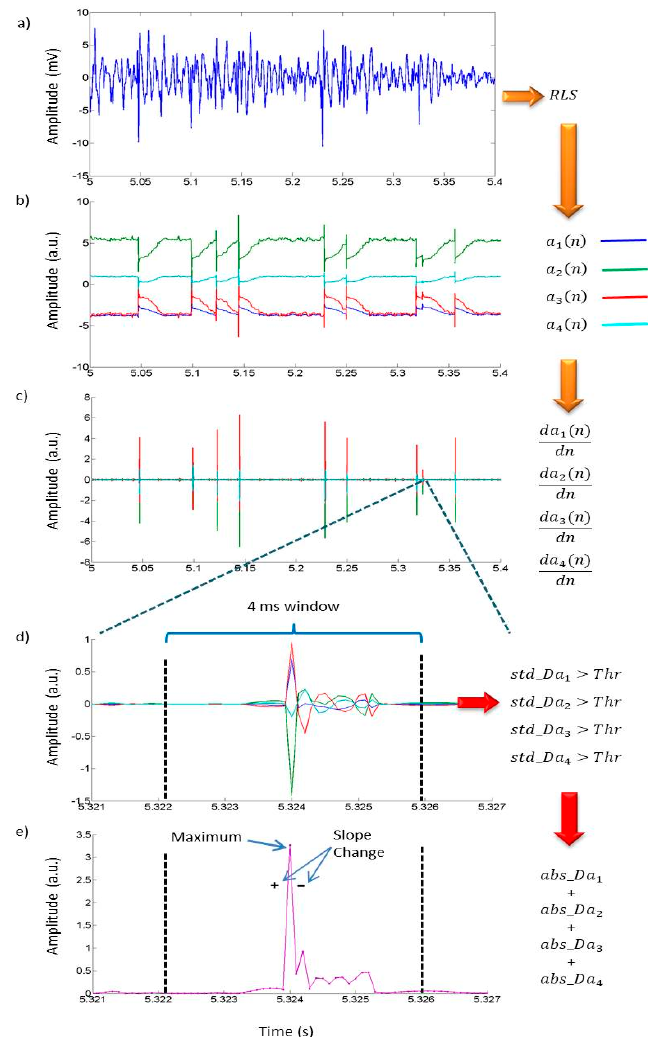
Figure 5. Schematic illustration of the processing steps implemented in the mobile app for the automated detection of respiratory crackles. ( a ) The sound signal s FN [ n ] is modeled using a 4th order TVAR model. ( b ) RLS-TVAR coefficients and their abrupt changes by the presence of crackles around 5.05 s, 5.1 s, etc., ( c ) Derivates of the coefficients time series in ( b ) where the abrupt changes are emphasized. ( d ) Segmenting of each coefficients time series derivates (TSD) by sliding 4 ms window where a threshold value is employed to determine presence of crackles. ( e ) If presence of crackles is detected inside a window for all the derivates then add the absolute values of the TSD and the maximum is found. The time location of the maximum is regarded as the starting point of the detected crackle